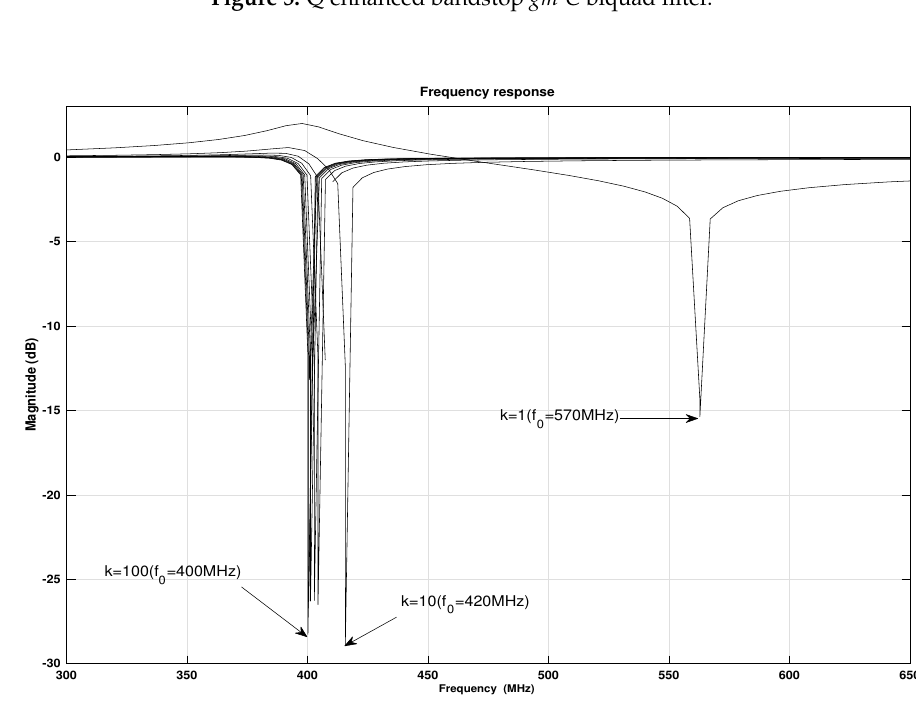
Figure 6. Frequency shift produced by the scaling factor, k of the kC